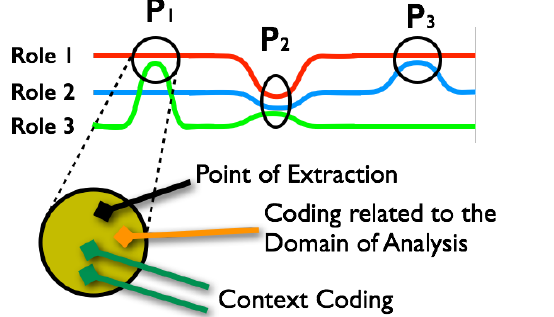
Fig. 1. The BNML Approach to Narrative